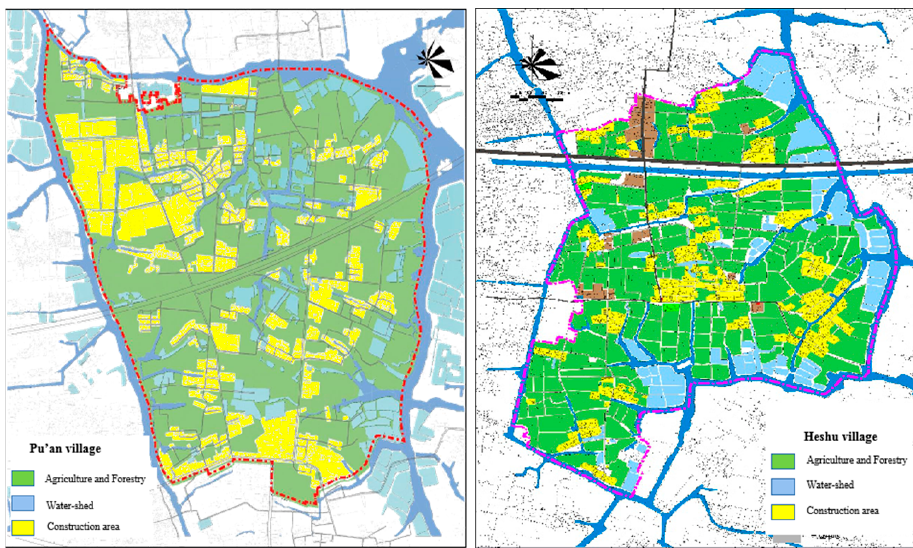
Figure 2. Land use in Heshu village and Pu’an village. Table 1. Land use in Heshu village and Pu’an village in 2016.